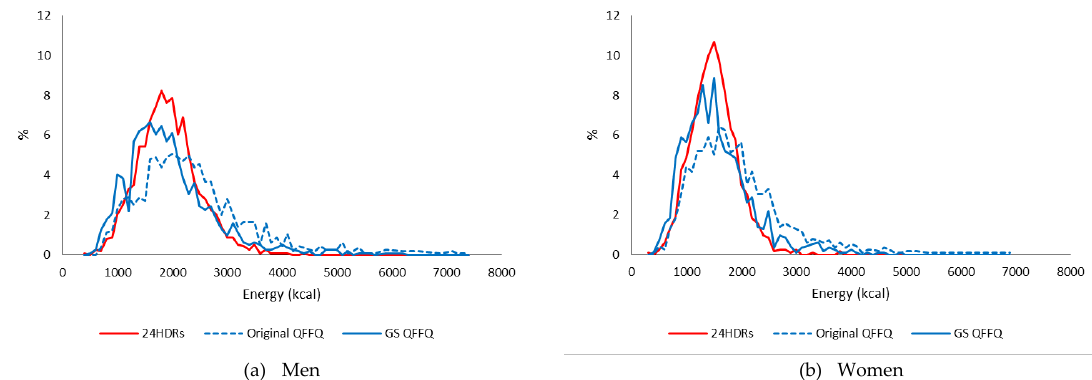
Figure 1. Distributions of energy intake estimated from 24 h dietary recalls (24HDRs) and those from